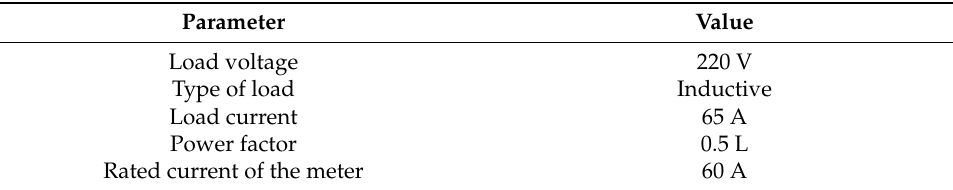
Figure 5. Schematic diagram of the circuit connections. Table 2. Test